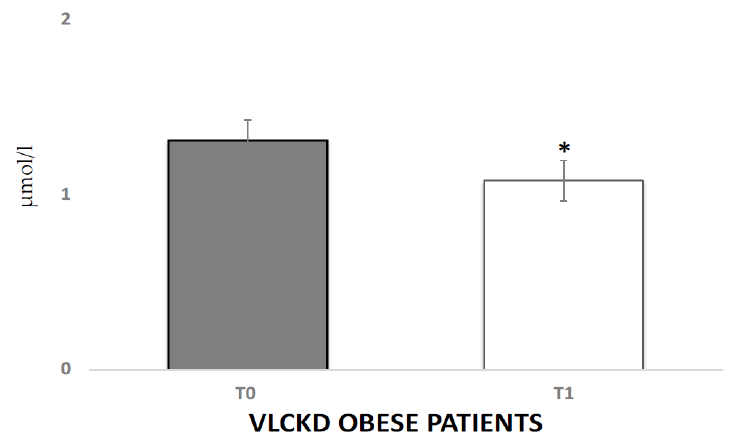
Figure 1. Salivary cortisol levels before and after the VLCKD in obese subjects. μ mol/l (mi- cromole/litro); (*) inidcates a significant difference ( p < 0.05) with respect to the basal value.